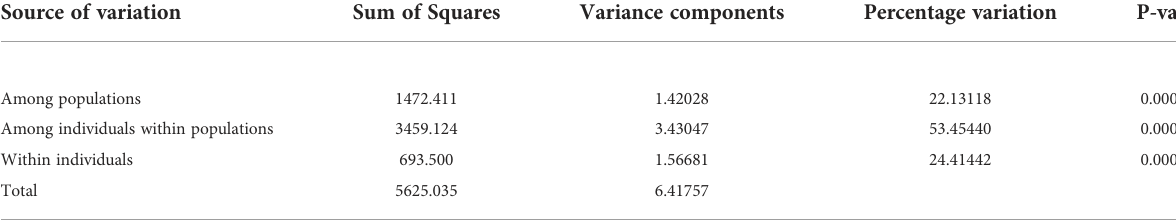
TABLE 3 Analysis of molecular variance (AMOVA) of nipa populations across the Indo-West Paci fi c using 18 SSR loci. Source of variation Sum of